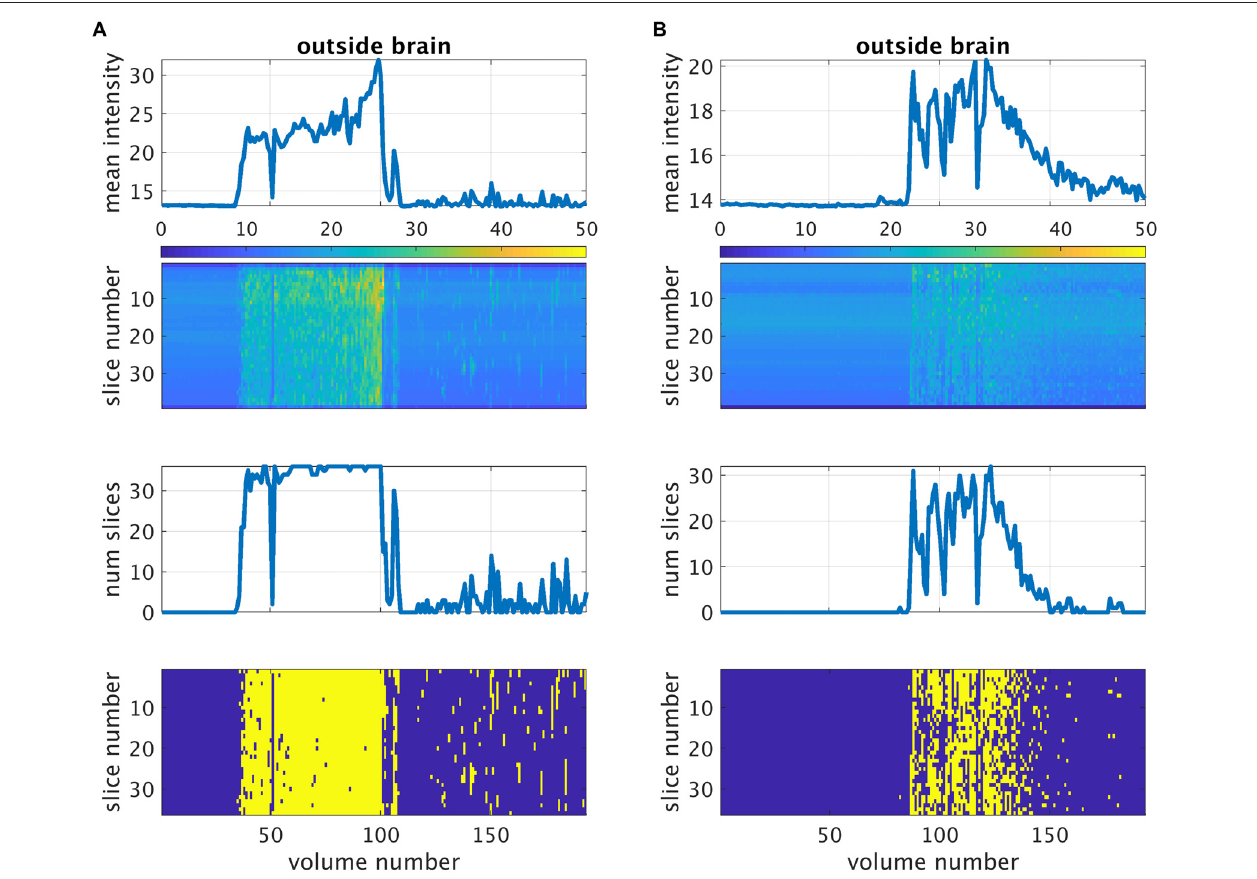
FIGURE 5 | Detection of gradient coil noise using the approach described in the main text for two representative datasets from subject 001 (A) and subject 002 (B) . The first row is the mean intensity of all voxels within the individualized outside-brain mask plotted against volume number. The second row is the mean intensity per slice. The third row is the number of slices affected by the gradient coil noise plotted against volume number as detected by the described method. The last row shows the same information per slice (shown in yellow). For this analysis, the threshold value was set to 3.